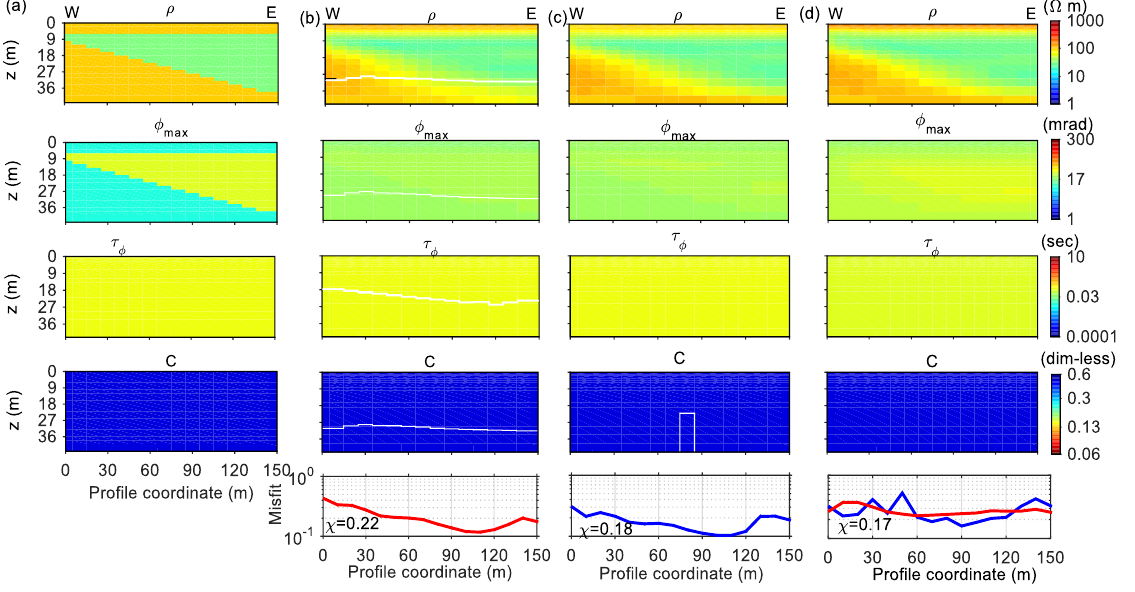
Figure 15. Comparison between the true model ( a ) and estimated MPA parameters of the subtle chargeable medium by x -data only ( b ); z -data only ( c ); and x and z data ( d ). The meanings of the curves and the area are the same as in Figure 7.